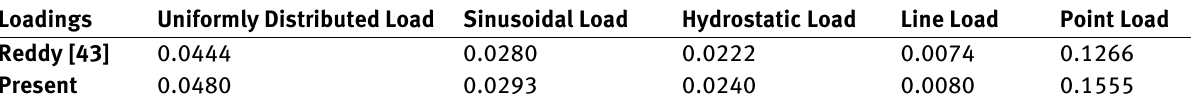
Table 8: Validation of displacements for different loading conditions on square simply supported isotropic plate Loadings